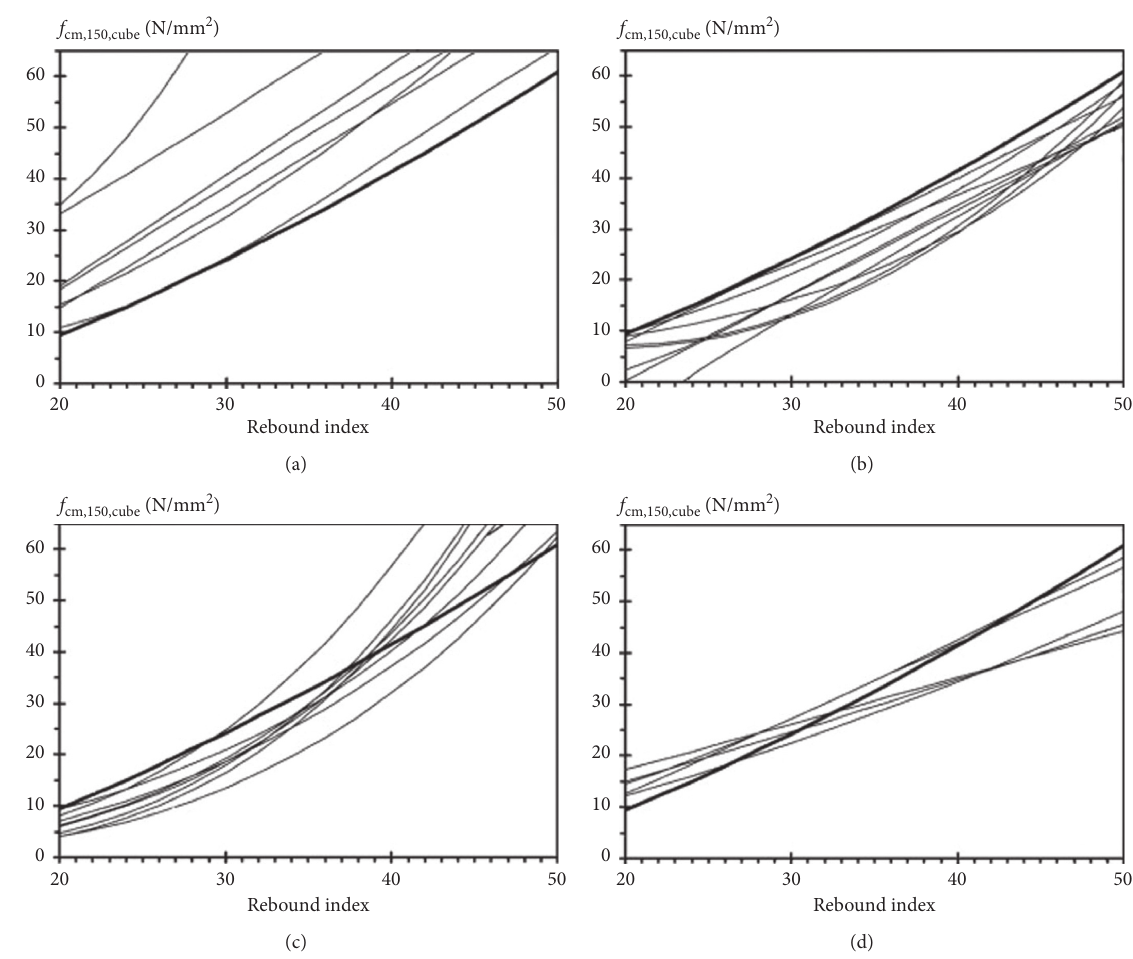
Figure 2: Calibration curves for the rebound hammer that can be found in the literature [11]. Calibration curves: (a) all above; (b) all below; (c) from below to above; (d) from above to below the original Schmidt calibration curve.